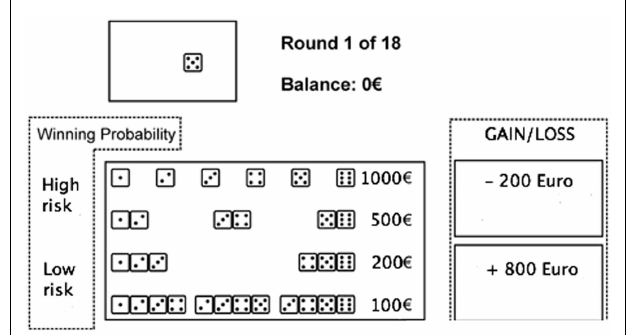
FIGURE 2 |The game of dice task . Before each trial, subjects have to decide between a single number, a combination of two numbers, three numbers, or four numbers.Thereafter, the dice are tossed (animated on the screen) and the result is presented. At the same time, an acoustic signal indicates whether the throw was successful or not, and the gain or loss is shown. Furthermore, the amount of capital changes depending on the received gain or loss, which is shown